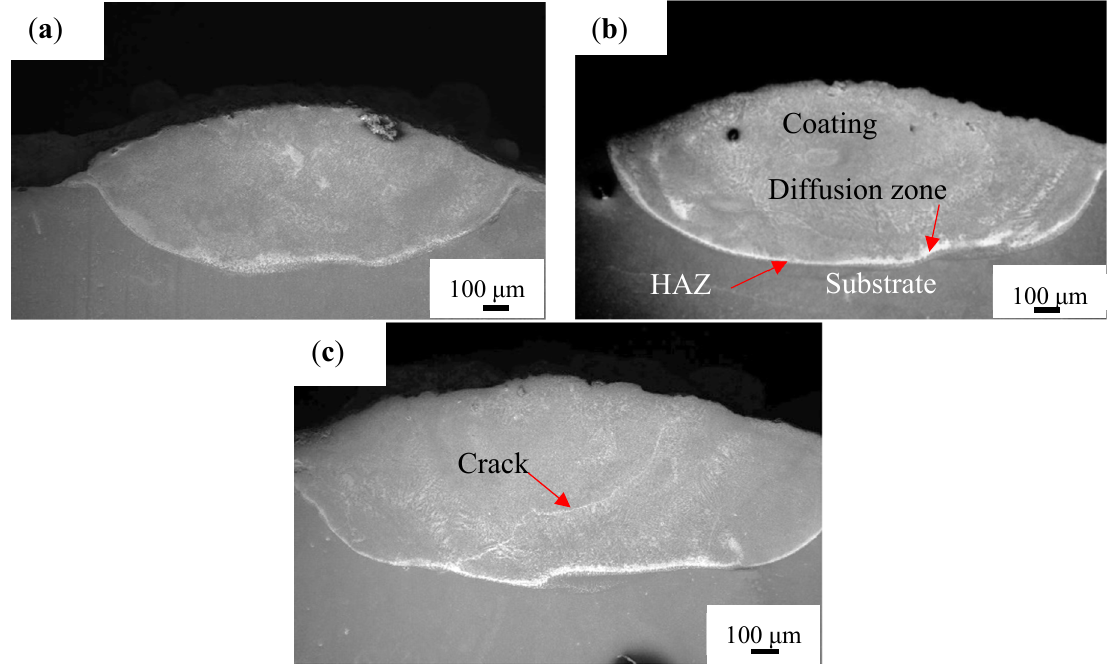
Figure 3. The overall morphology of coatings on the cross section. ( a ) Ti-Al-Si, ( b ) Ti-Al-Si-6TiC and ( c ) Ti-Al-Si-10TiC.